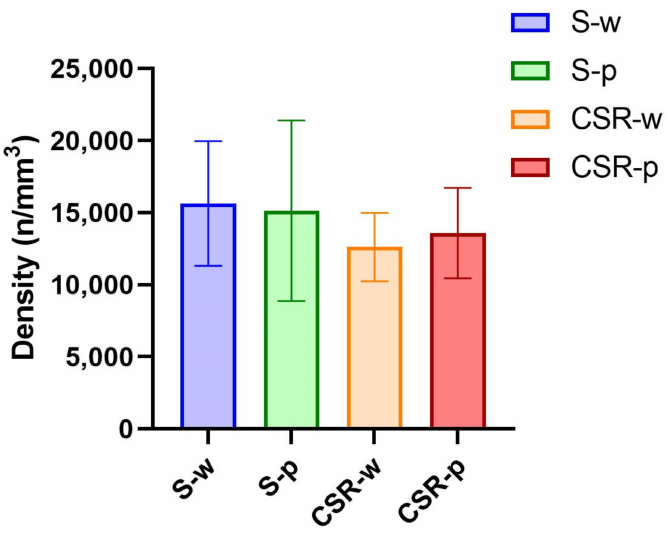
Figure 7. Quantification of the Sholl analysis of microglia process arborization. Number of intersec- tions in S-w and S-p ( A ), in S-w and CSR-w ( B ), in S-p and CSR-p ( C ), and in CSR-w and CSR-p ( D ). N = 7 for each group, values are mean ± SD.